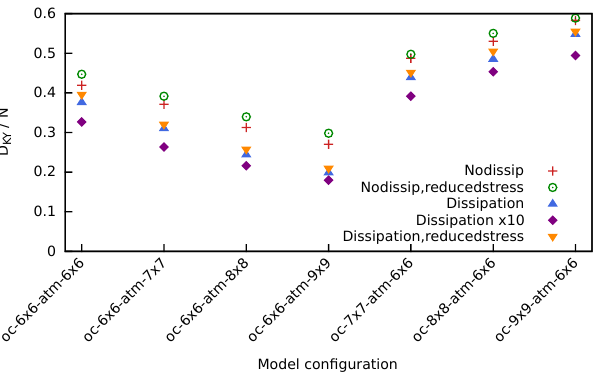
Figure 19. Kaplan–Yorke or Lyapunov dimension D KY of MAOOAM divided by the total number of dimensions N , as a func- tion of the model configuration.